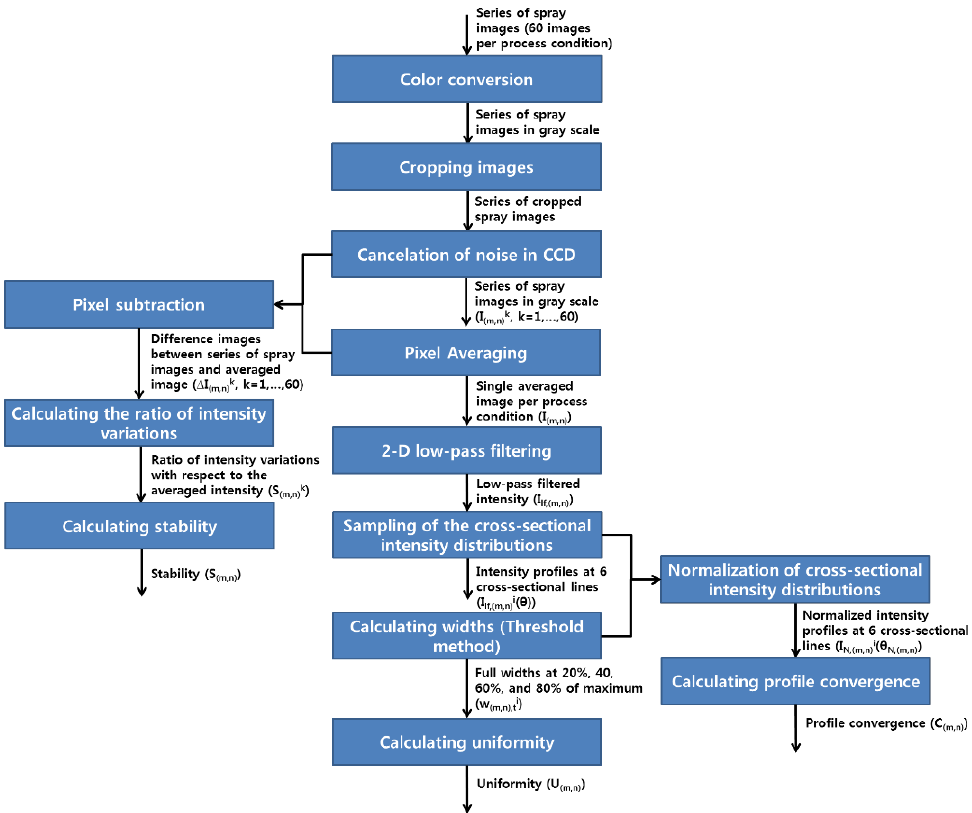
Figure 4. Flow chart of the algorithm for quantifying the characteristics of the spray